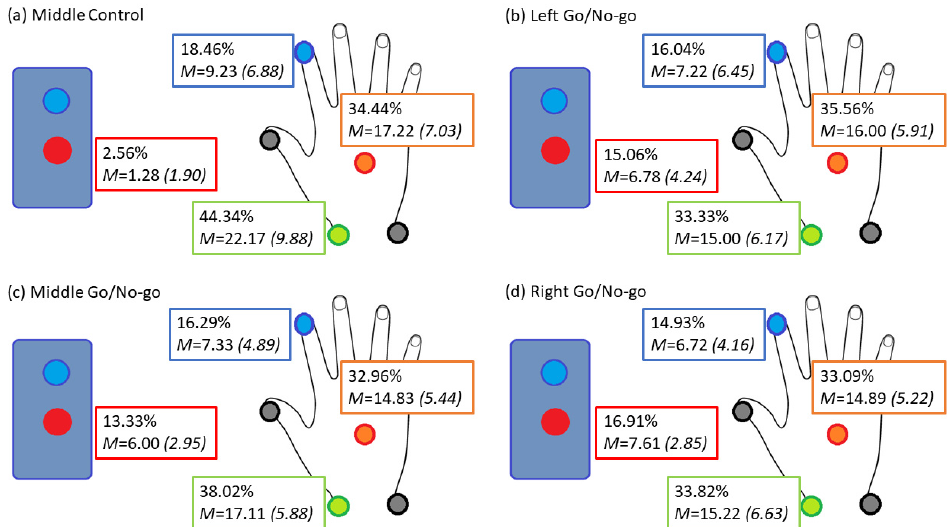
Figure 4. A schematic of the average percentage of how often each marker was used to calculate RT as the first measure of movement. Percentages are shown for each of the four tasks: for the middle practice block, left Go/No-Go, middle Go/No-Go and right Go/No-Go. Possible markers measured include the button release (red), index finger (blue), back of hand (orange) and medial wrist (green).